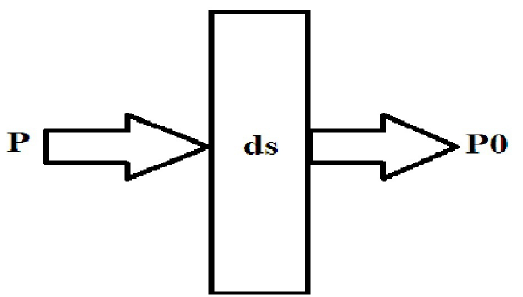
Figure 5 - Beer Lambert